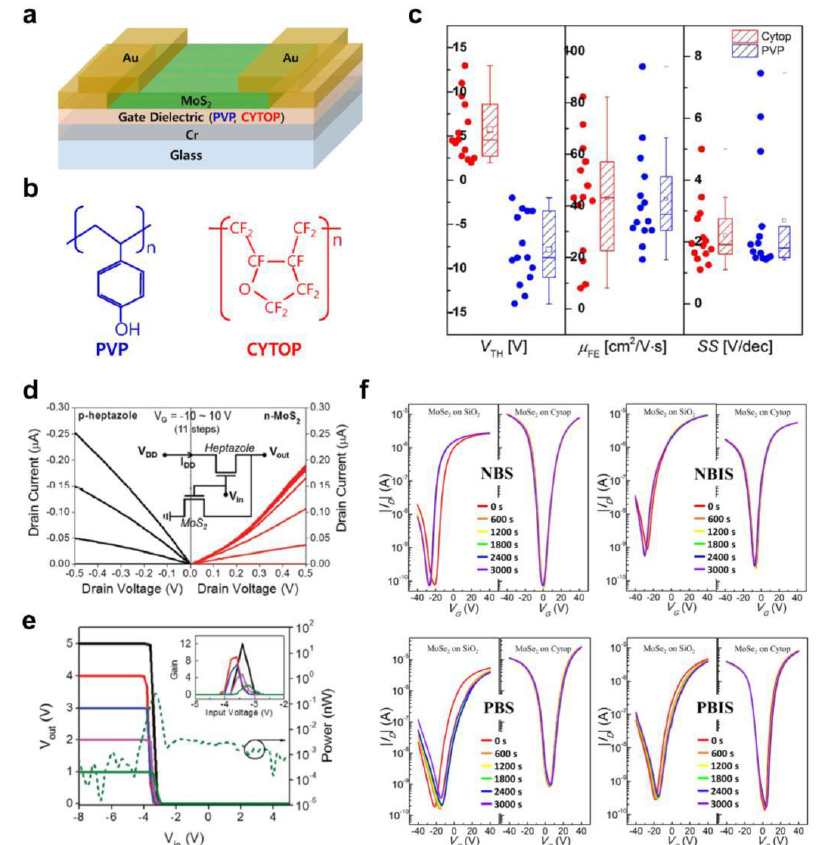
Figure 2. ( a ) Device structure for 2D MoS 2 FETs based on polymer dielectric materials and ( b ) the chemical structures of PVP and CYTOP. ( c ) The V T , μ , and SS distributions for 14 2D MoS 2 FET devices [68]. Copyright © 2016, AIP Publishing. ( d ) The output curves of the p − type heptazole OFET and n − type 2D MoS 2 FET, which both utilized a CYTOP/Al 2 O 3 bilayer dielectric, and ( e ) the VTC curves of the resulting hybrid CMOS inverter according to the V DD (inset: voltage gain profile) [39]. Copyright © 2015, John Wiley and Sons. ( f ) Changes in the transfer curves in the NBS (top left), NBIS (top right), PBS (bottom left), and PBIS (bottom right) measurements for 2D MoSe 2 FETs with a CYTOP interfacial layer compared to those without CYTOP [69]. Copyright © 2021, Elsevier.